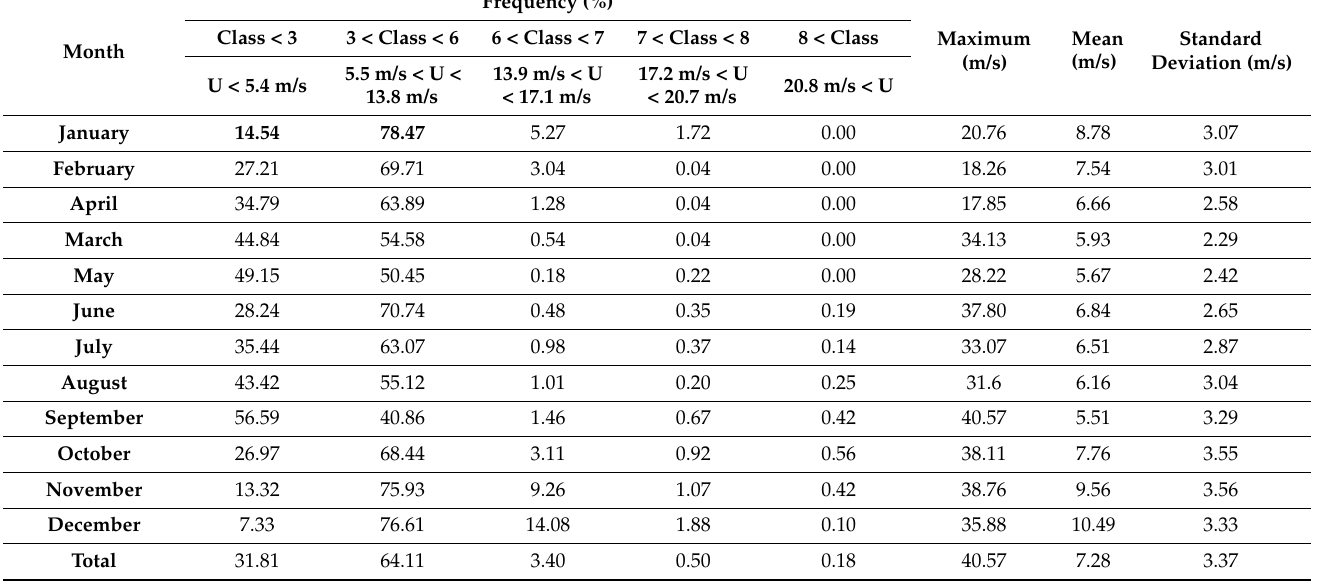
Table 2. Wind speed classification at the Xisha Islands.